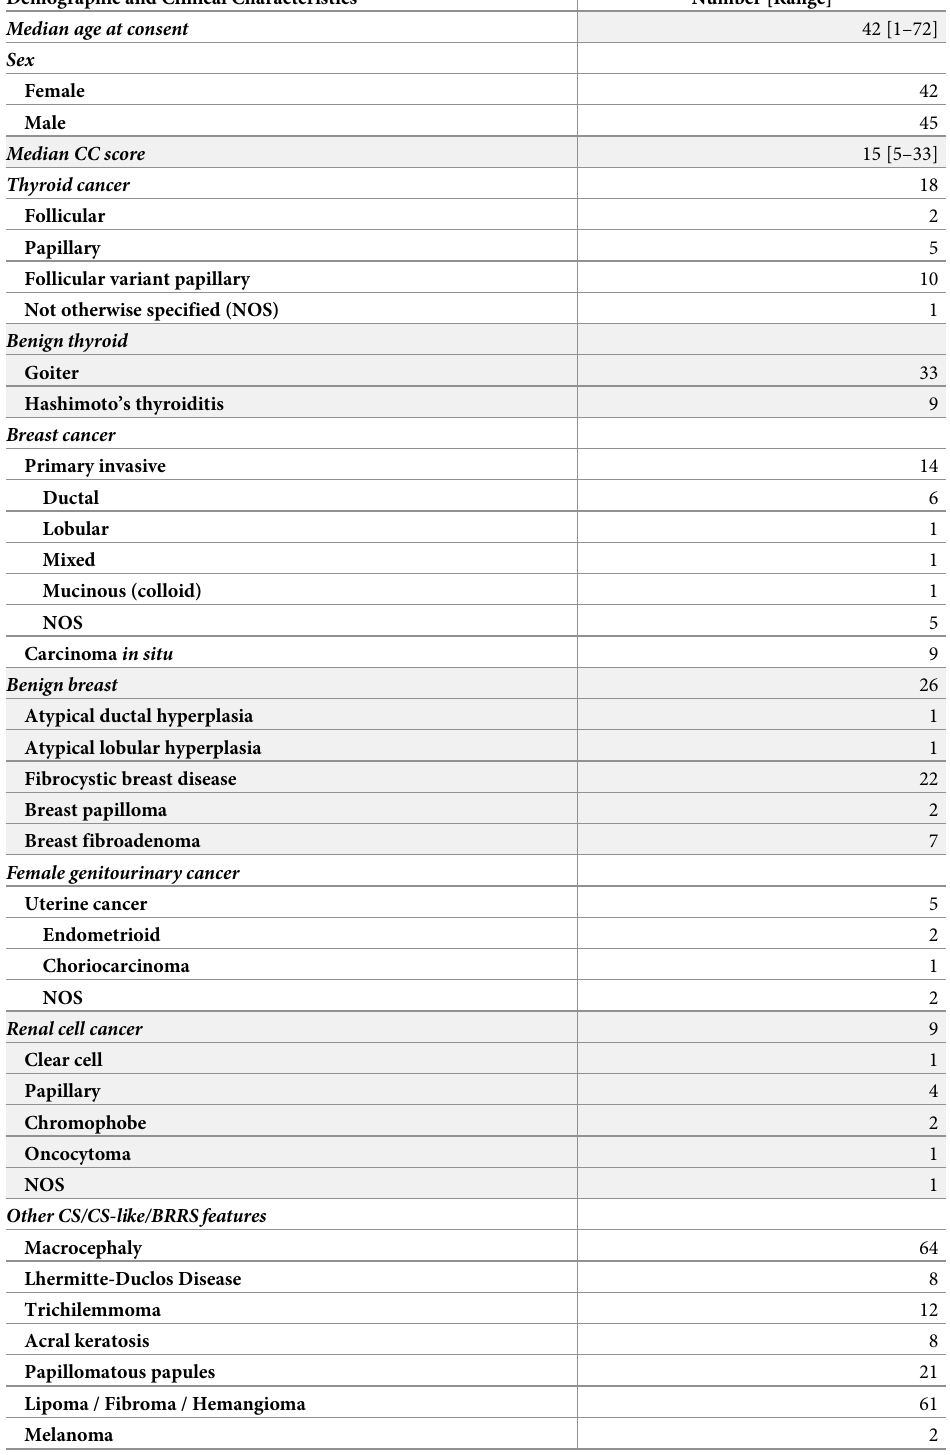
Table 1. Demographic and clinical characteristics of 87 PTEN wildtype Cowden/Cowden-like syndrome and Ban- nayan-Riley-Ruvalcaba syndrome